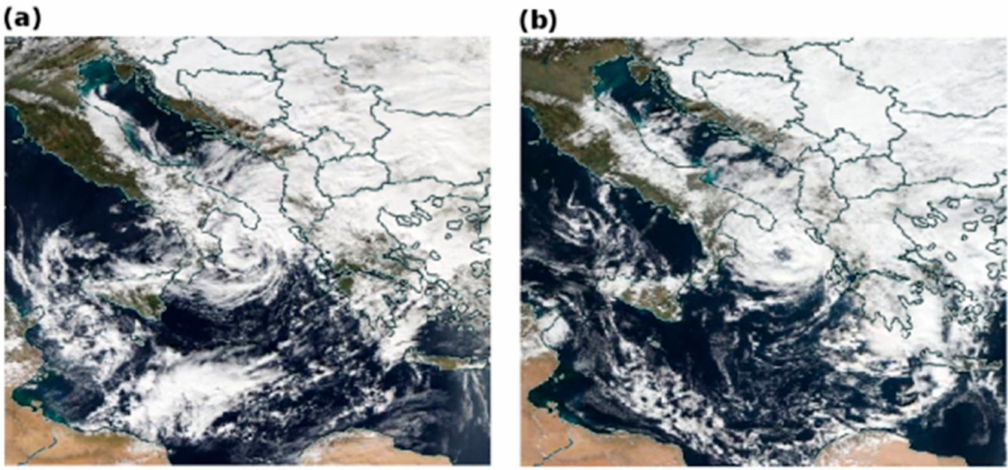
Figure 4. ( a ) MODIS / Aqua reflectance for 17 October 2017 and ( b ) VIIRS / NPP Suomi reflectance for 18 October 2017.